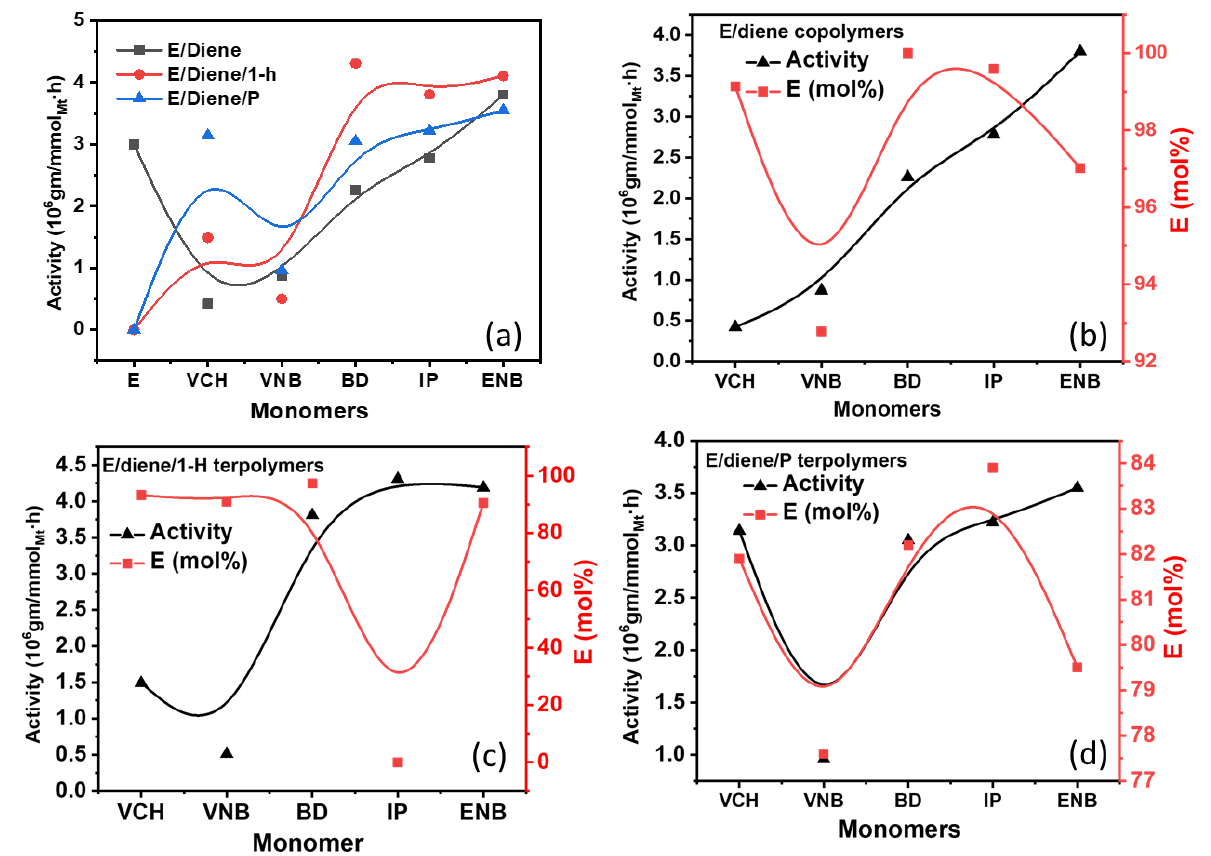
Figure 1. ( a ) Graph of polymerization activity between E/diene, E/diene/1-hexene and E/diene/propylene polymerizations, ( b ) comparison of E content and activity in E/diene copolymers, ( c ) comparison of E content and activity in E/diene/1-hexene terpolymers, ( d ) comparison of E content and activity in E/diene/propylene terpolymers. Table 1. E/diene, E/diene/1-hexene and E/diene/propylene polymerization catalyzed with ( rec -